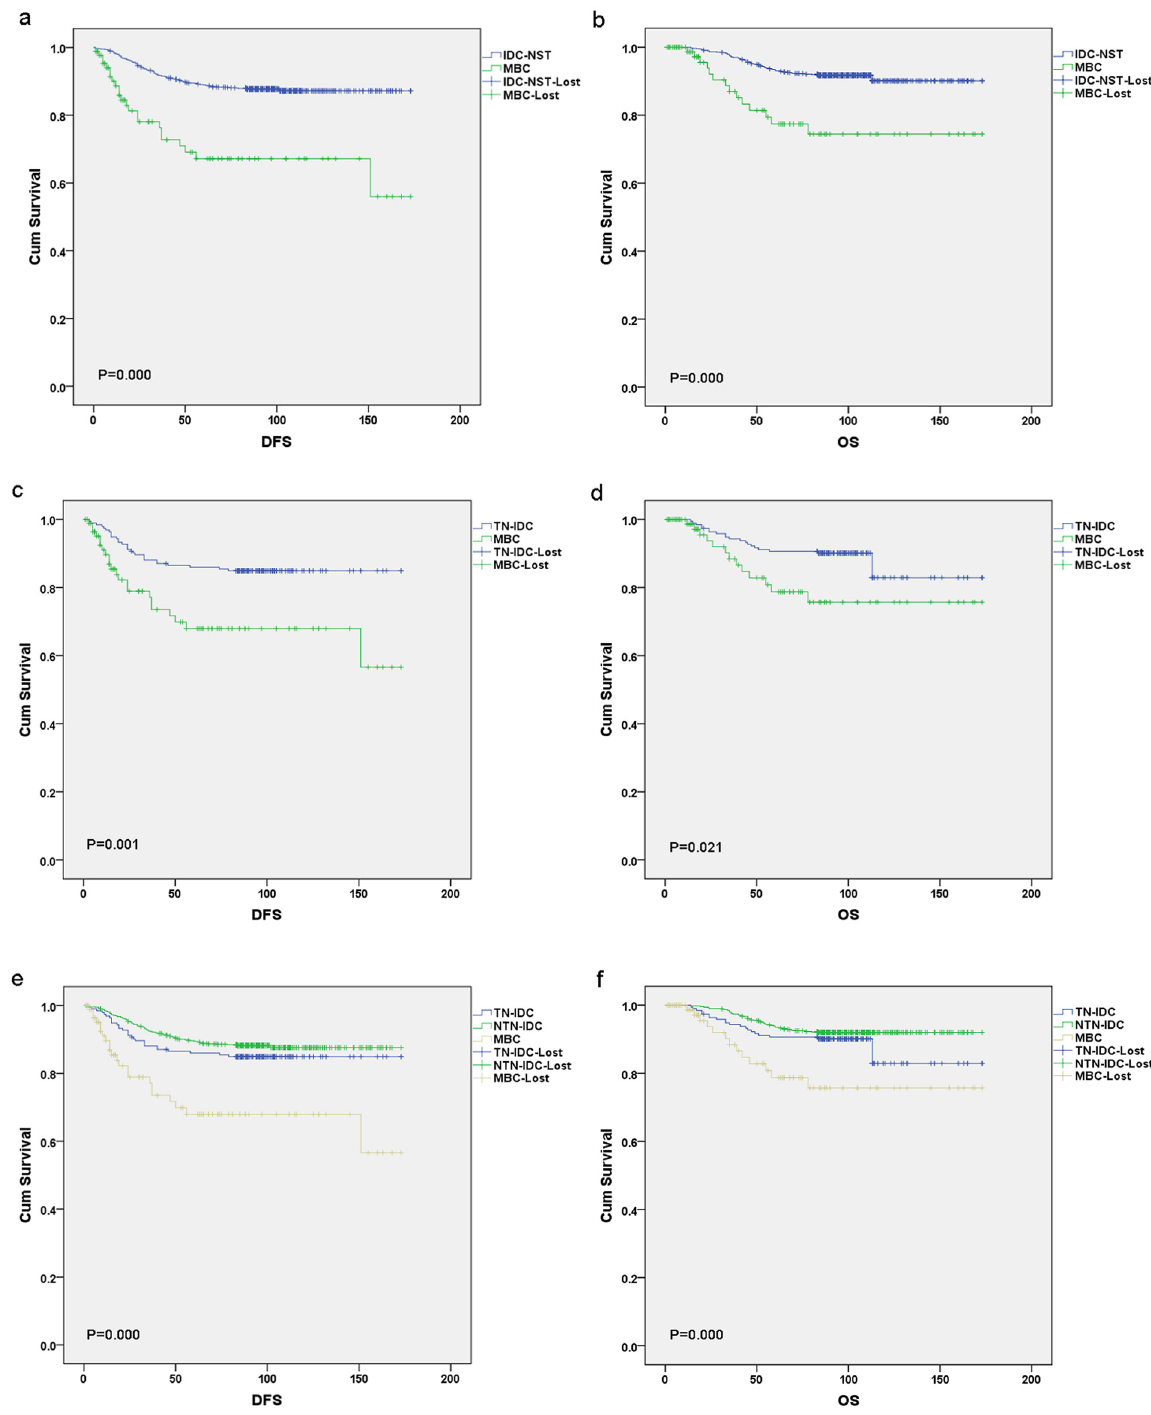
Fig 2. Patient ’ s survival curves of MBC, IDC-NST and TN-IDC. Patients with MBC demonstrated shortened five-year DFS and five-year OS, when separately compared with those in the IDC-NST (a and b) and TN-IDC groups of patients (c and d). Group comparison analysis among MBC, TN-IDC and non-triple negative IDC (NTN-IDC) showed that patients with MBC had the worst five-year DFS and OS followed by TN-IDC, while NTN-IDC carried the most favorable five-year DFS and OS among the groups (e and f).